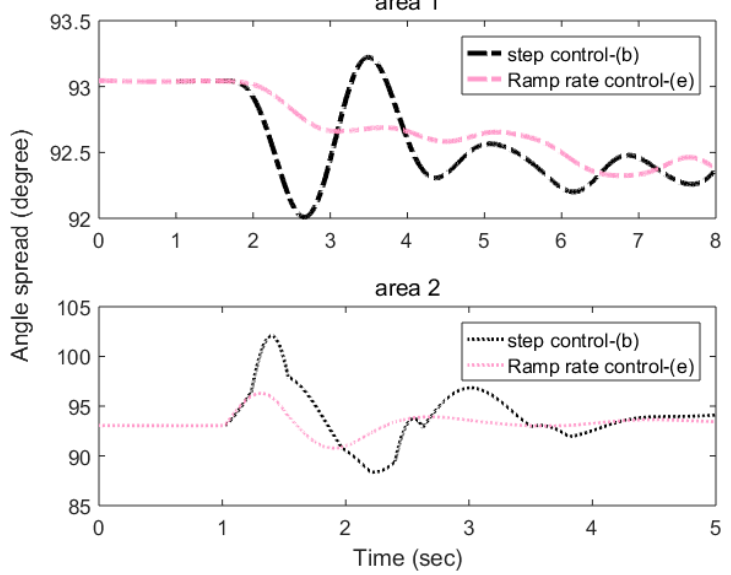
Figure 16. Angle spread results of each area according to (a) and Figure 16. angle spread results of each area according to (a) and (e). Figure 16. angle spread results of each area according to (a) and (e).